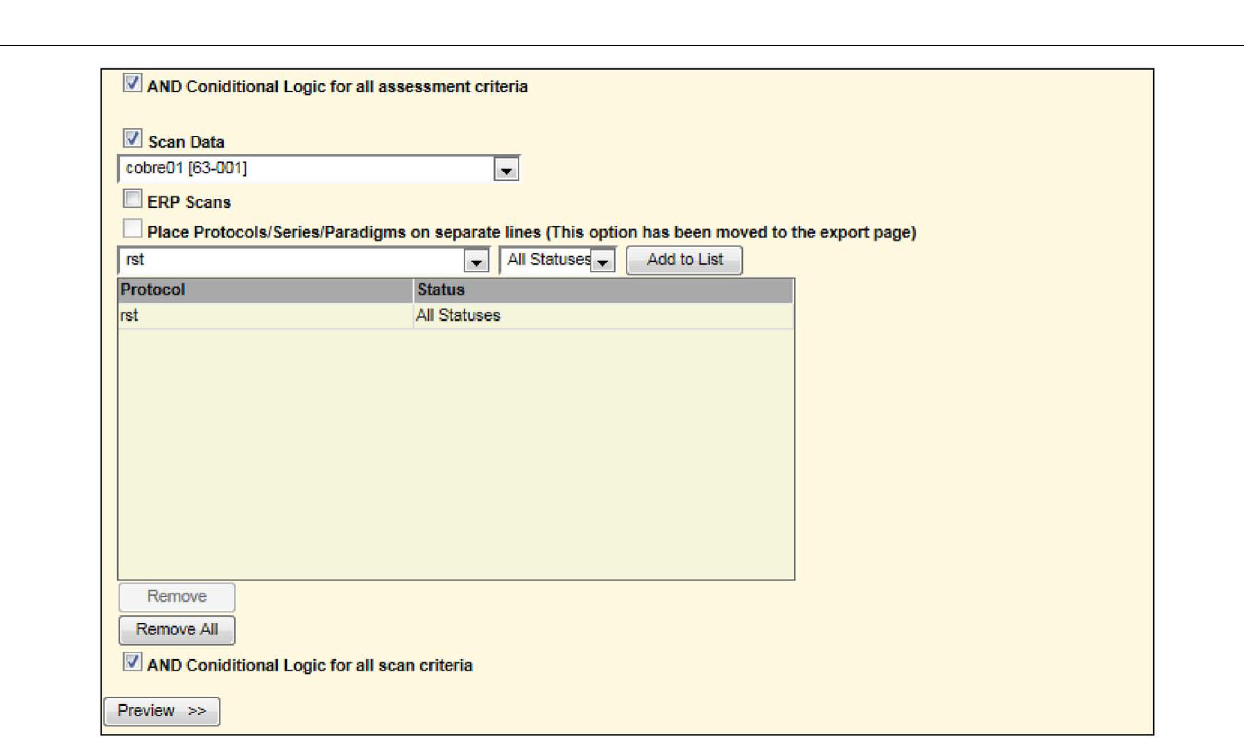
FIGURE 7 | Second portion of screen in query builder requesting all rst (rest) scans for one study to be combined with all handedness in a different study (Figure 6). This is similar to a union of all subjects between the two studies matching the specified